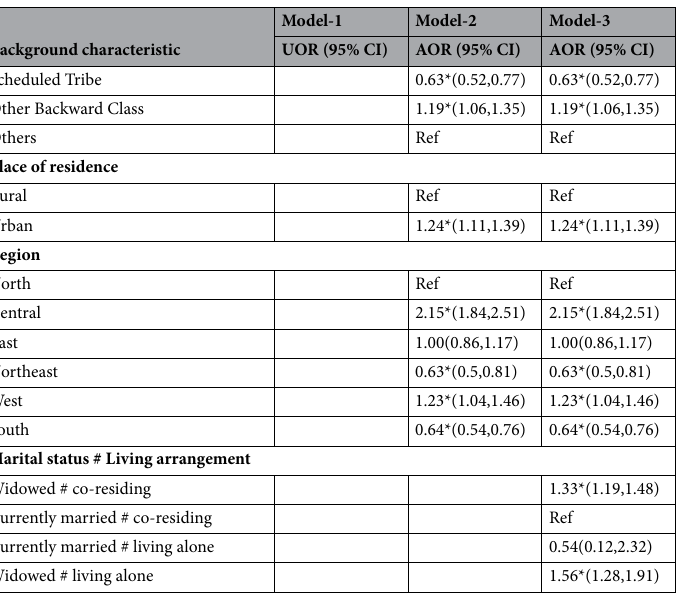
Table 3. Logistic regression estimates for older adults suffering from depression by their background characteristic in India. # : Interaction; Ref: Reference; *if p < 0.05; AOR: Adjusted odds ratio; CI: Confidence interval; ADL: Activities of Daily Living; IADL: Instrumental Activities of Daily Living; Model-1 was controlled for marital status and living arrangement; Model-2 and 3 was controlled for marital status, living arrangement, age, sex, education, working status, social participation life satisfaction, self-rated health, difficulty in ADL, difficulty in IADL, morbidity status MPCE quintile, religion, caste, place of residence,